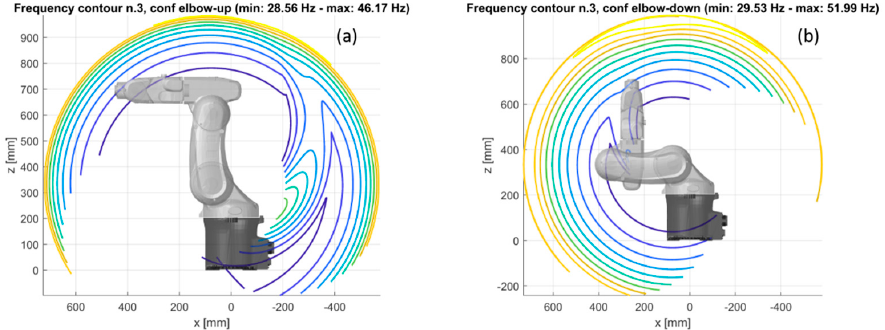
Figure 15. Contour plot of the natural frequency of mode 2 in the meridian plane, ( a ) elbow-up, ( b ) elbow-down.